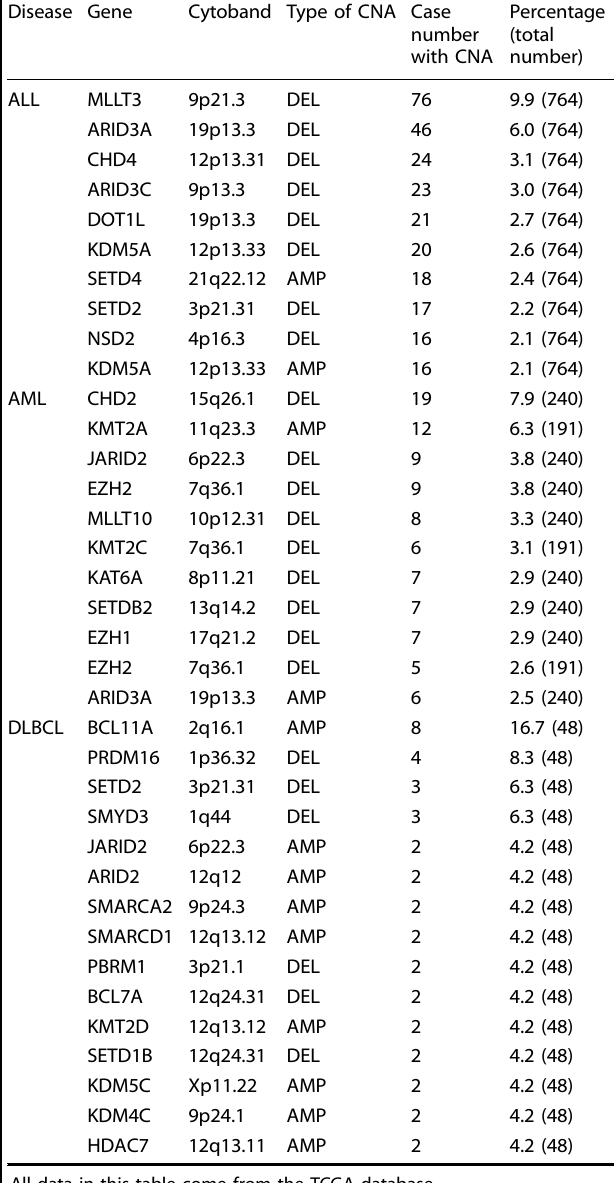
Table 4. Transcriptional cofactors with high frequency of abnormal copy numbers in hematological